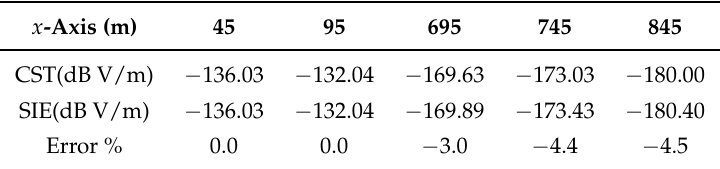
Table 4. Electric field in the z -direction component at test point ( x ,0, − 500 ) . x -Axis (m)